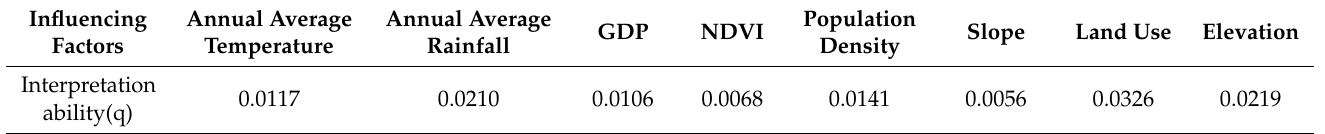
Table 6. q value of influencing factors of habitat quality change of Liulin.